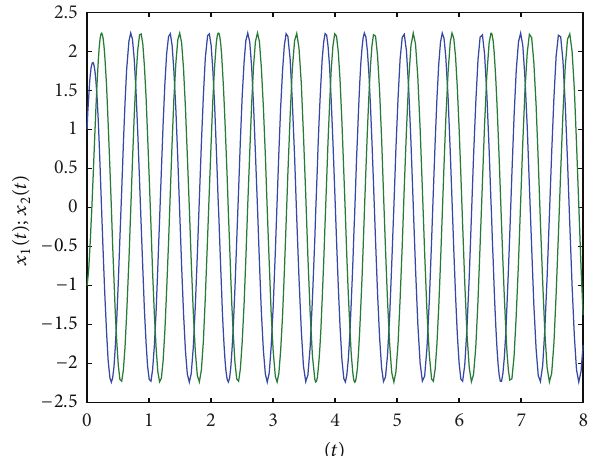
Figure 4: 𝑥 1 (𝑡) and 𝑥 2 (𝑡) of the nonlinear system (1a) and (1b), with 𝑎 = 10, 𝑐 = 𝑐 = 𝑘 = 1, 𝑖 = 2, 𝑟 = 5, 𝑑 = 0.2, [𝑥 1 2